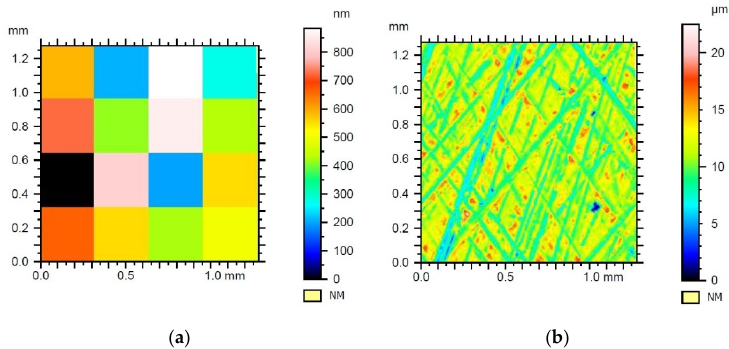
Figure 6. Results of filtration of the surface geometrical structure of sample 1 with Daubechies wavelet on the 1st row with the 1st level of filtration—( a ) waviness, ( b ) roughness.